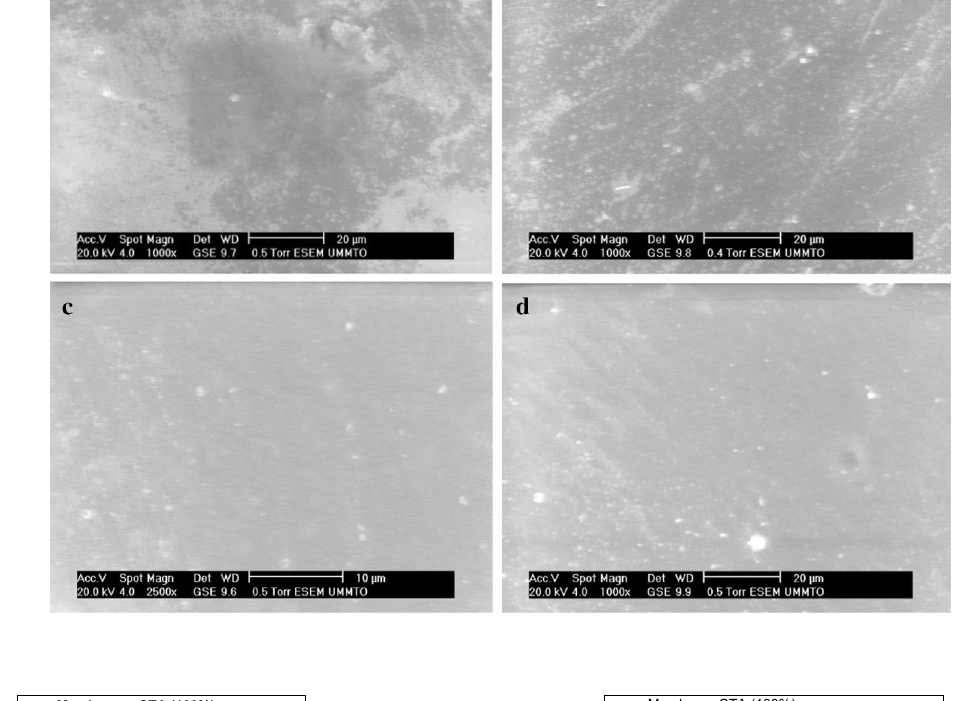
Fig. 3 : SEM Micrographs of developed PIMs; a CTA 100% + RC8(0.0( g/g poly- mers) + 2-NPOE (0.4 mL)/g polymers, b (CTA 75% + CA